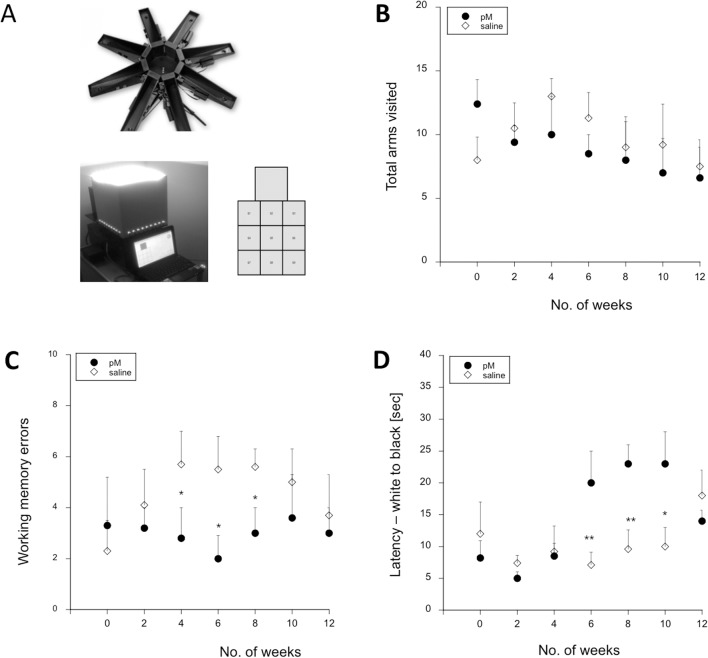
Cognitive function in monocyte-infused APPSwDI mice.Spatial learning and memory were assessed using a modified win-shift procedure in an 8-arm maze (A) every two weeks. Intravenous infusions of 5 x 106 young monocytes (pM, filled circle; n = 8) or saline (unfilled diamond; n = 7) took place at 0, 4, and 8 weeks. To test memory function, animals were evaluated for total number of visits (B) to radial arms, and working memory errors (C) measured over two sessions. Anxiety was tested using a black/white box (A) over 5 sessions and quantified by the number of seconds it took the animal to leave the white area (D). Plotted data represents the mean ± SEM performance of each animal group (n = 5). Statistical analysis was performed using a Student’s t-test (* p < 0.05, ** p < 0.01).